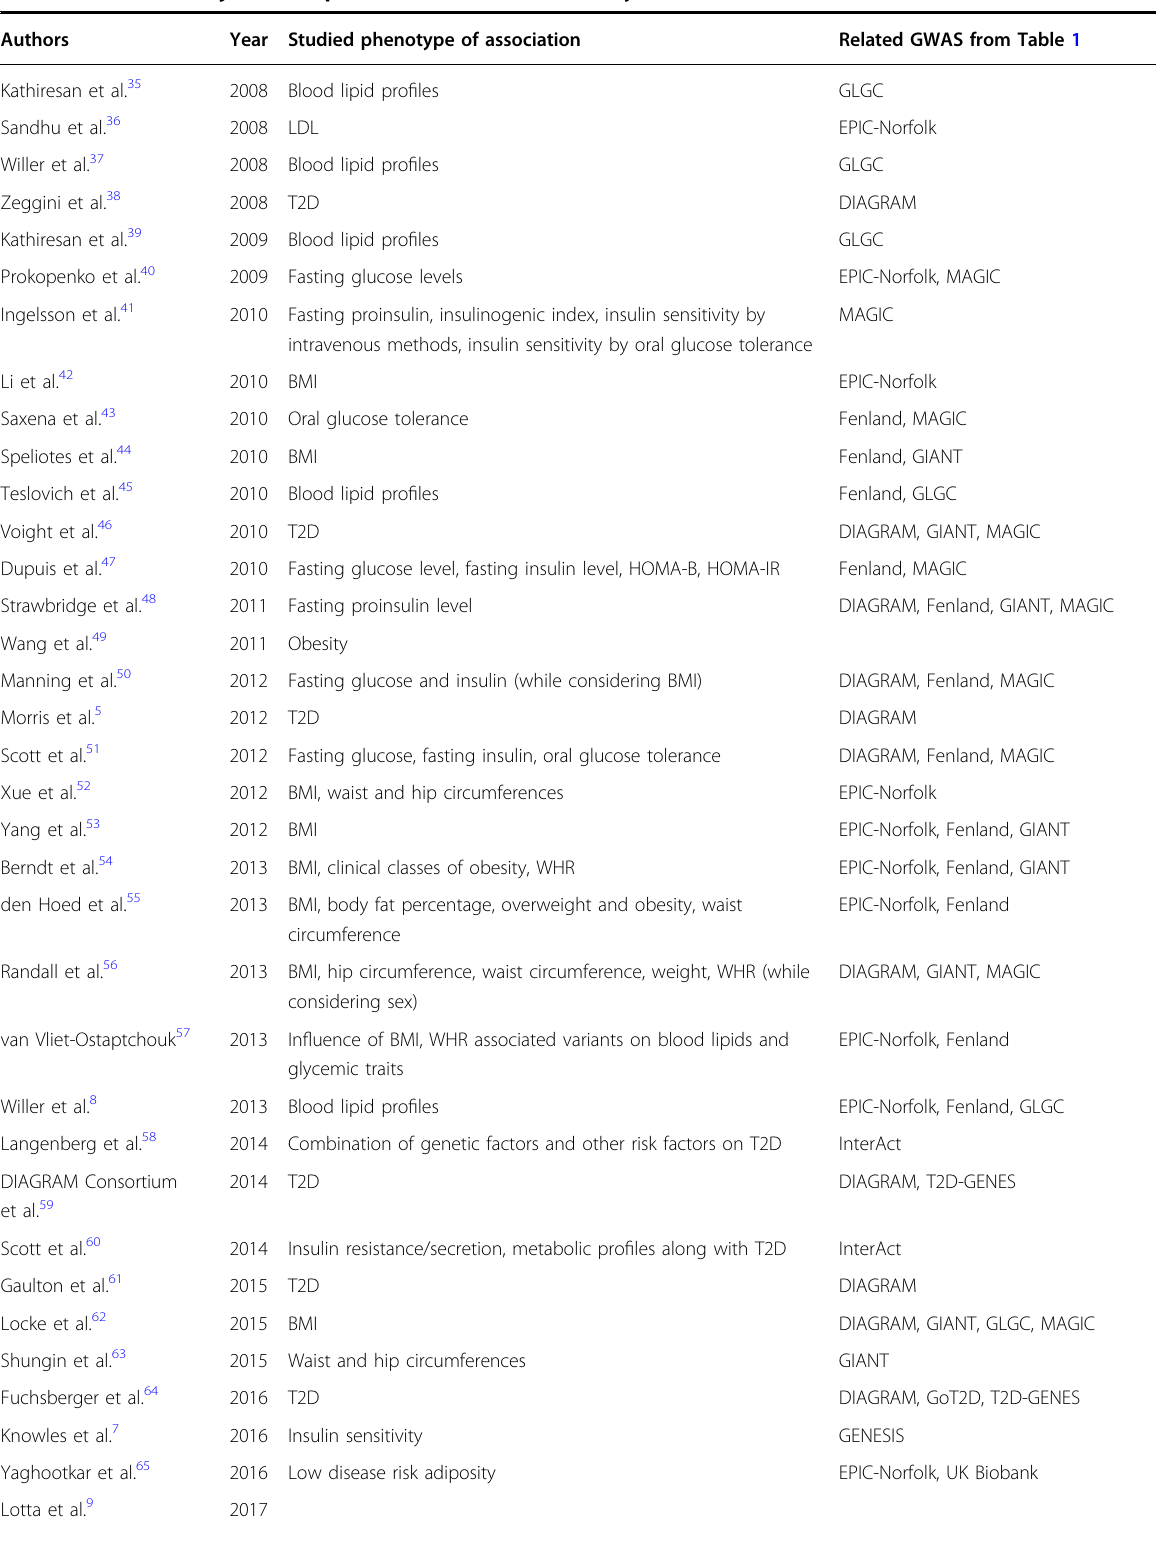
Table 2 Selected major GWAS publications related to obesity or